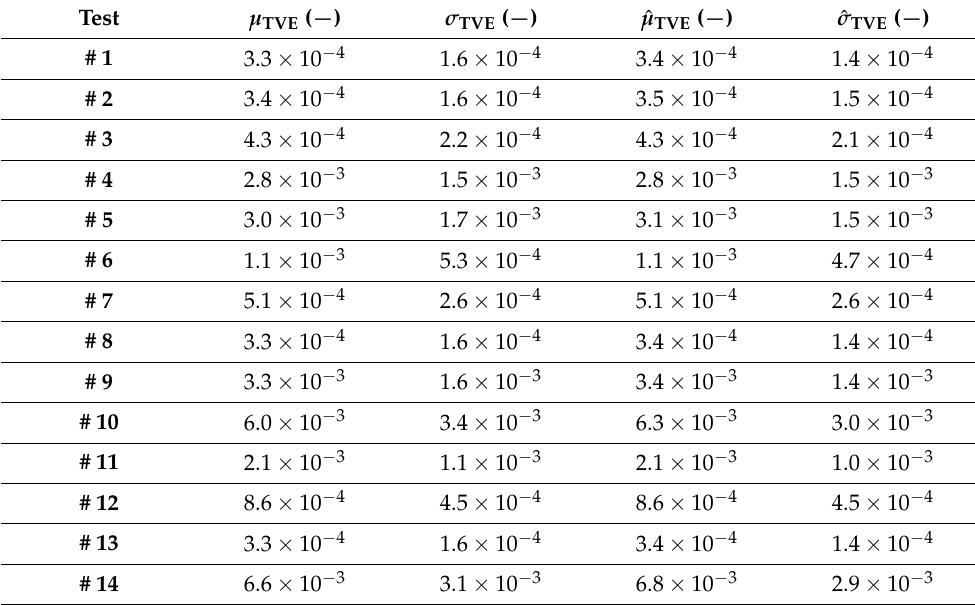
Table 3. List of the results from the MCM testing.